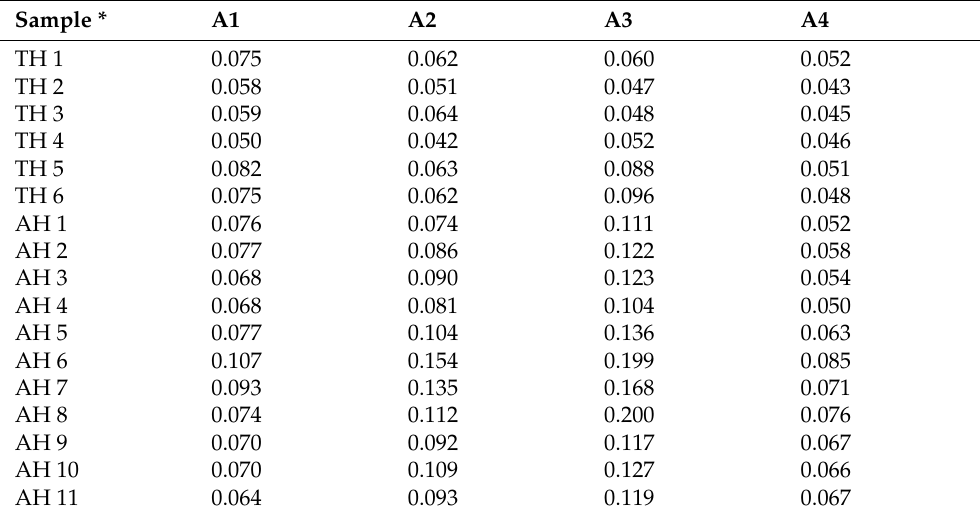
Table 2. RRs average data samples for each sensor.